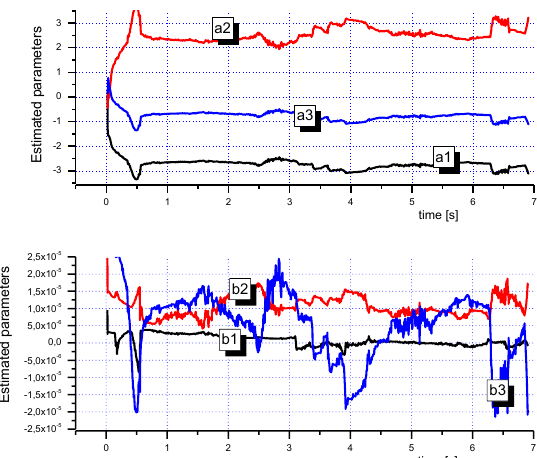
Fig. 4. Courses of identified model parameters (1) a i , b i